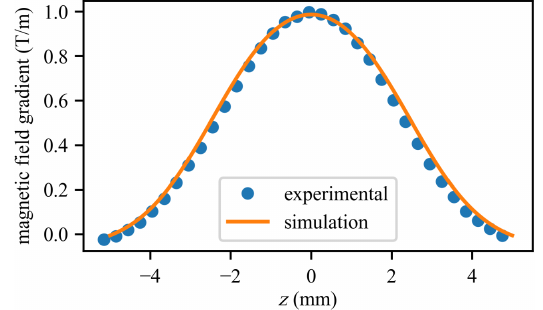
=dx ) along z axis at x ¼ y ¼ 0 y